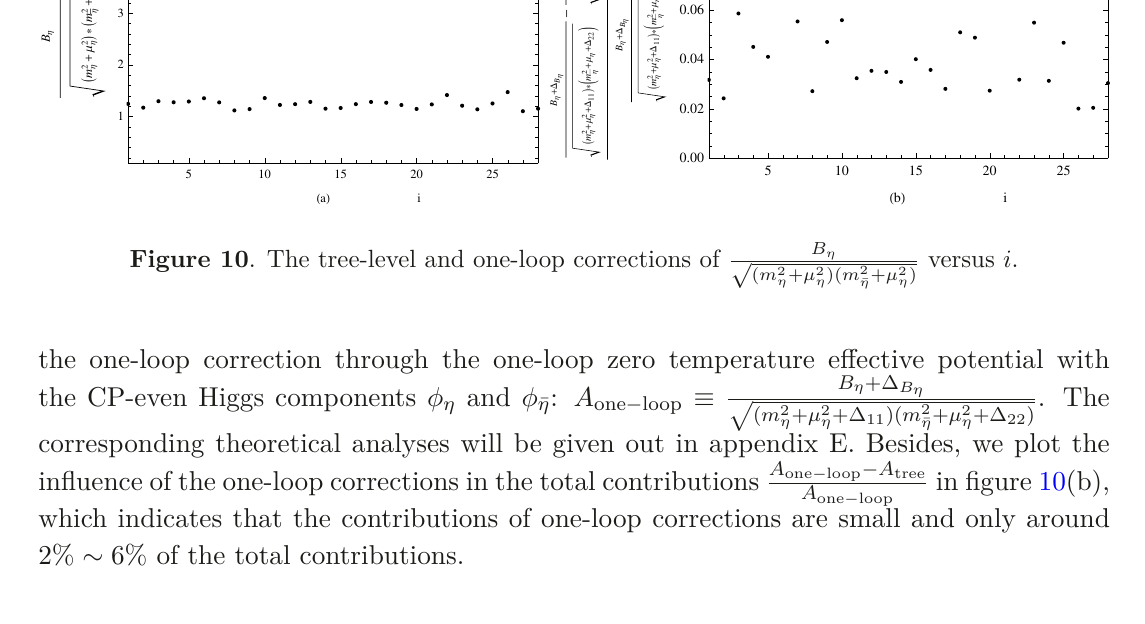
Figure 10 . The tree-level and one-loop corrections of B η